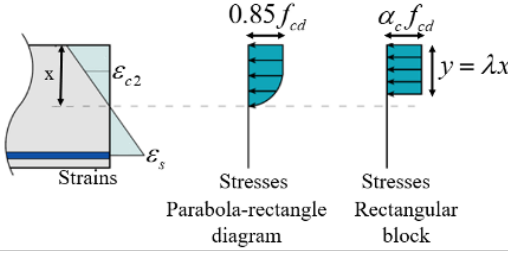
Figure 2. Strain and stress diagrams of concrete.